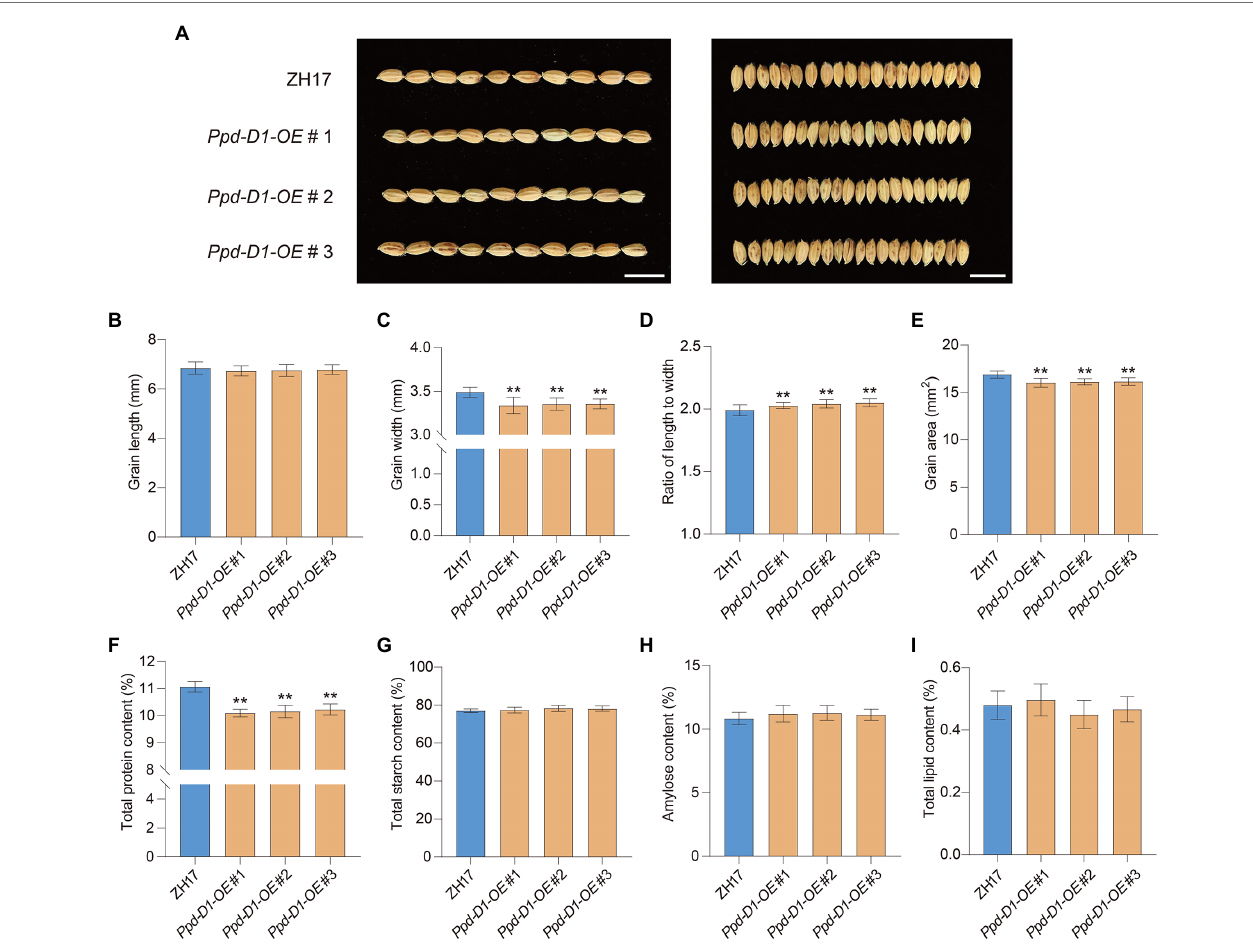
FIGURE 7 | Ppd-D1 affects grain size and quality in rice. (A) Comparison of grain size between Zhonghua 17 (ZH17) and Ppd-D1-OE transgenic lines. Scale bars = 1 cm. (B–E) Comparison of the grain length, grain width, the ratio of grain length to width, and grain area between ZH17 and Ppd-D1-OE (for each plant, n = 50). (F–I) Comparison of total protein content, total starch content, total amylose content, and total lipid content between ZH17 and Ppd-D1-OE (for each line, n = 5). Values are presented as mean ± SD. Phenotypic measurements of the transgenic plants were performed using three independent transgenic lines. Tukey’s test was performed between control and transgenic plants (** p <